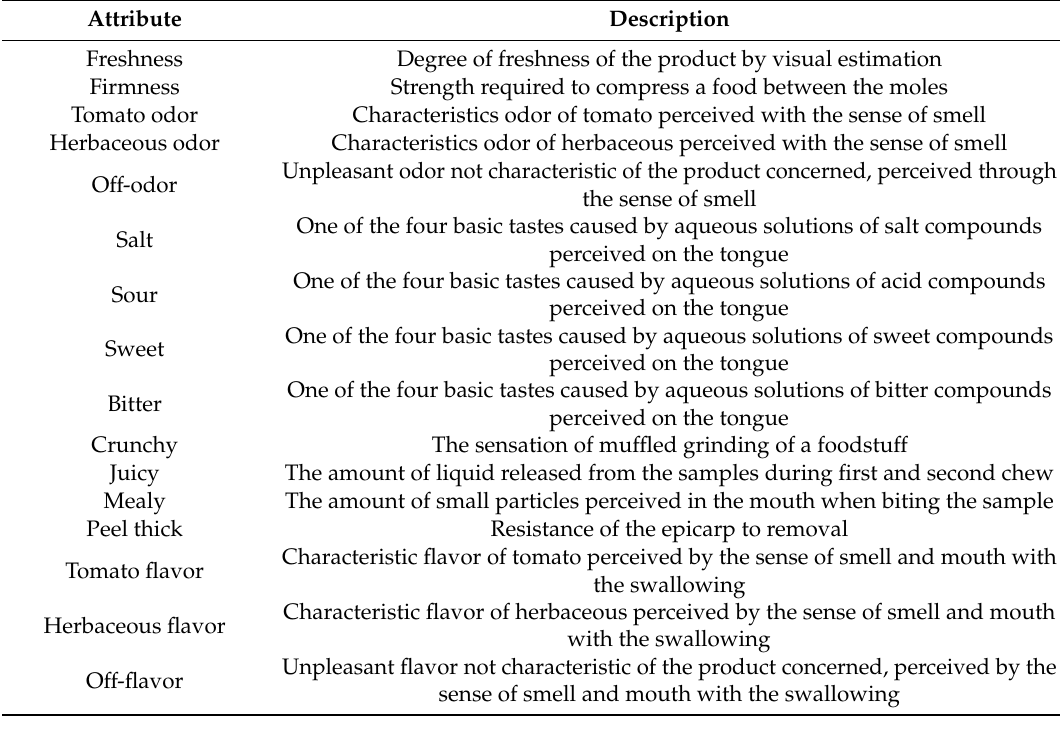
Table 1. List of evaluated sensory attributes and their